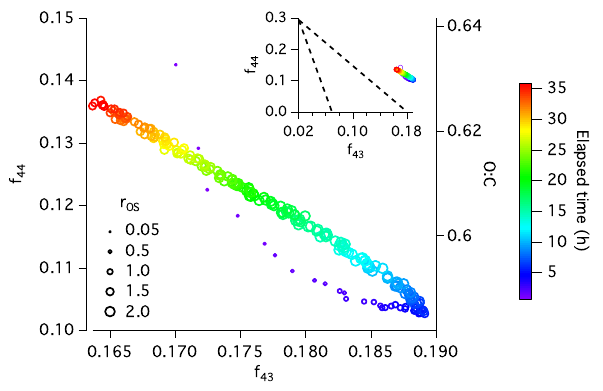
Fig. 5. Evolution of f 43 , f 44 , and O:C for 36 h of OH exposure. This system lies to the right of the triangular region in which typical ambient aerosol resides, as shown by the dashed lines in the inset (Ng et al., 2010). Marker size denotes the organic-to-sulfate ratio, r OS , of suspended particles.